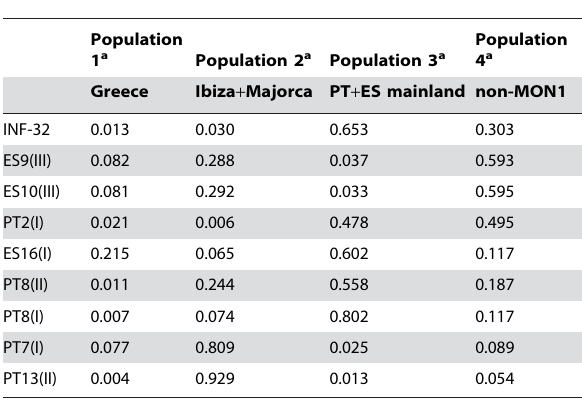
Table 3. Population membership coefficients of strains of combined MON-1/non-MON-1 genotypes or other mixed